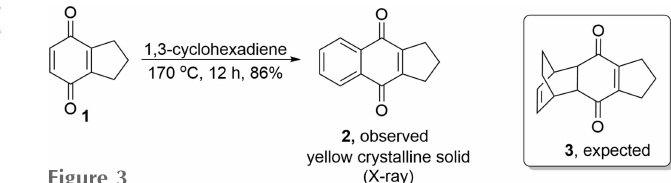
Figure 2 The crystal packing viewed along the b -axis direction.